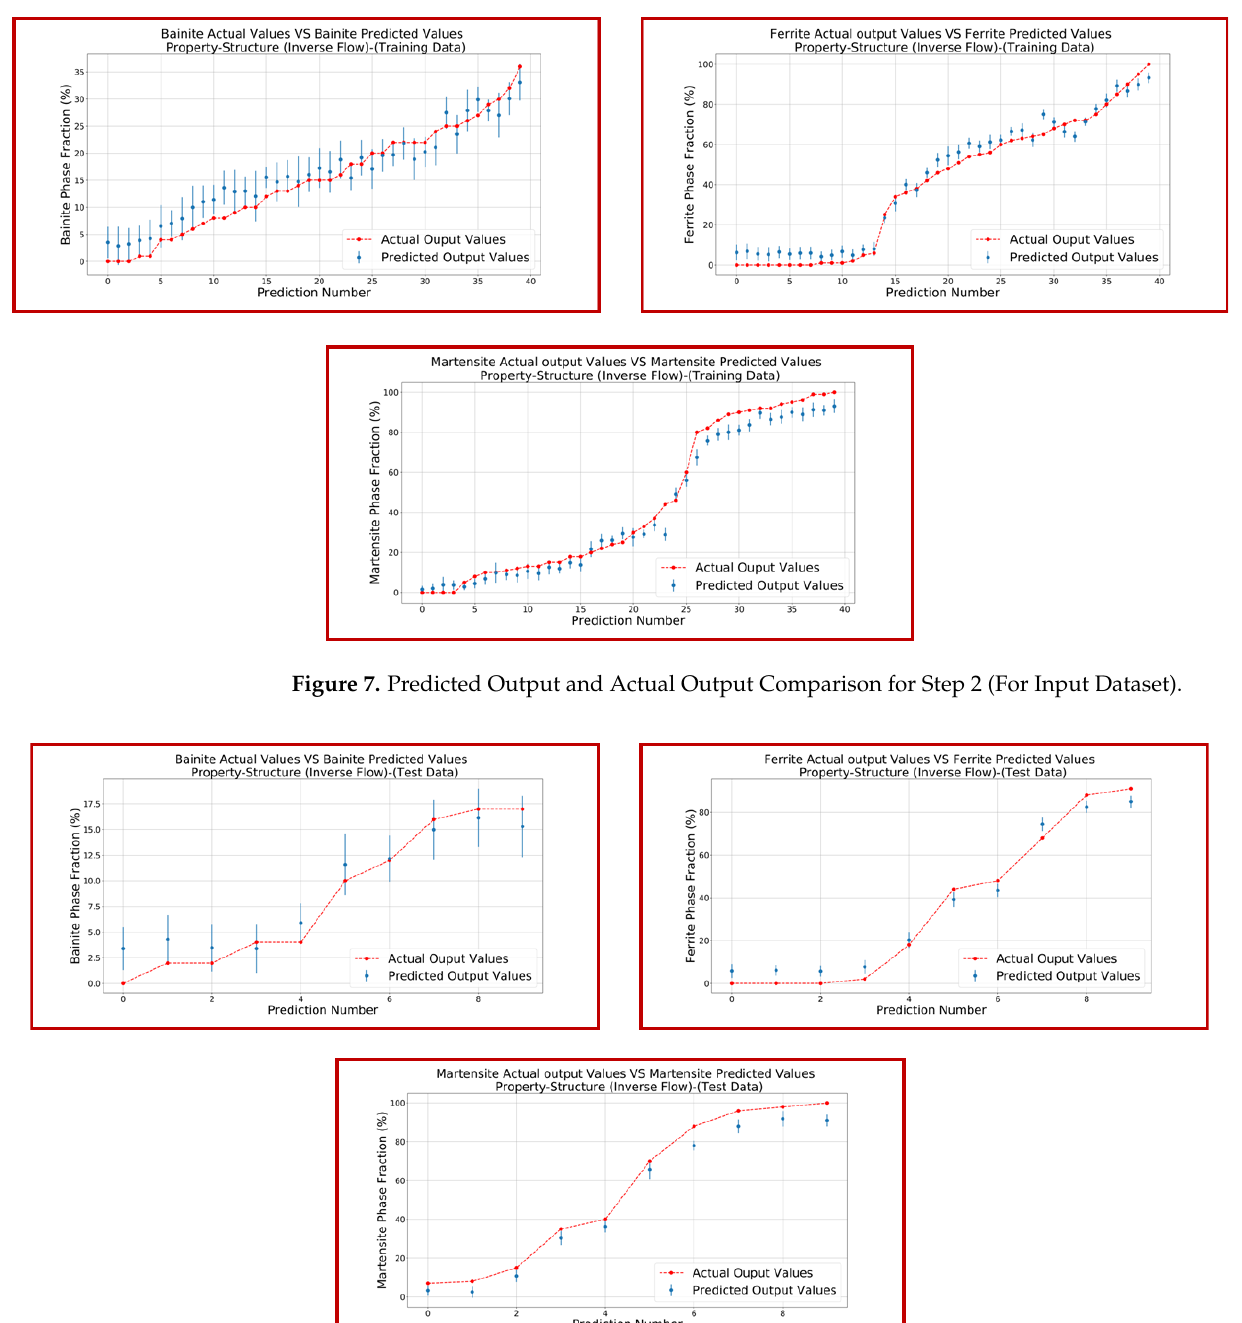
Figure 9. Feasible Region for Microstructure Parameters. The set of feasible phase fraction values of martensite, bainite, and ferrite were iden- tified as shown in Table 8. The loss function for step 3.1 was calculated as shown in Table 9. The Table 8 shows that the minimum phase fraction of martensite is 55.99%, while the maximum is 89.99%. Similarly, for bainite and ferrite, the minimum phase fractions are 9.99% and 4.3%, while the maximum phase fractions % are 16.55% and 23.55%, respec- tively. These identified phase fraction combinations satisfy the requirements specified by the designer. These combinations are converted to ranges as shown in Table 10. The de- sign information, these phase fraction combinations in the form of ranges, and is commu- nicated to step 3.1 as requirements or targets.